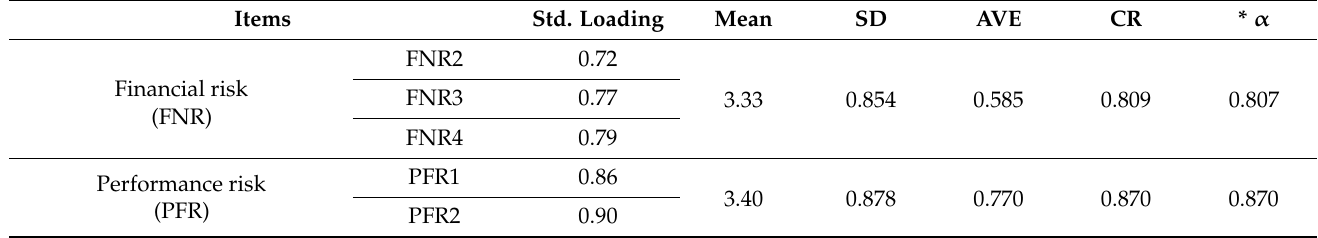
Table 3. Reliability, validity test, and means for latent